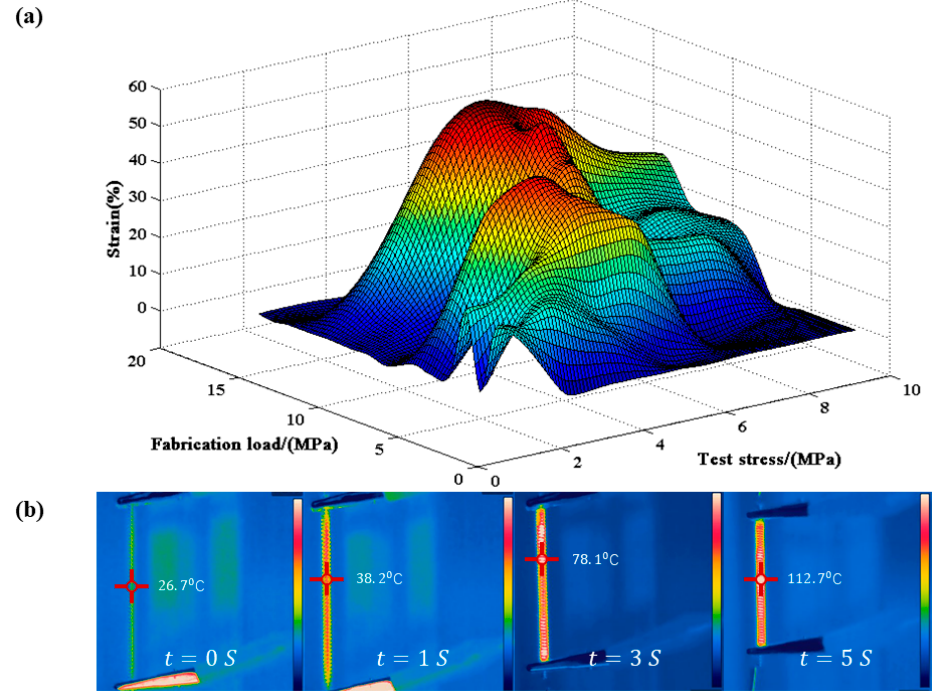
Figure 4. Strain test results of the TCP muscles ( a ) strain of TCP samples from various fabrication load and test stress and ( b ) the temperature distribution along the TCP muscle’s surface. The cursor indicates temperature at that spot.